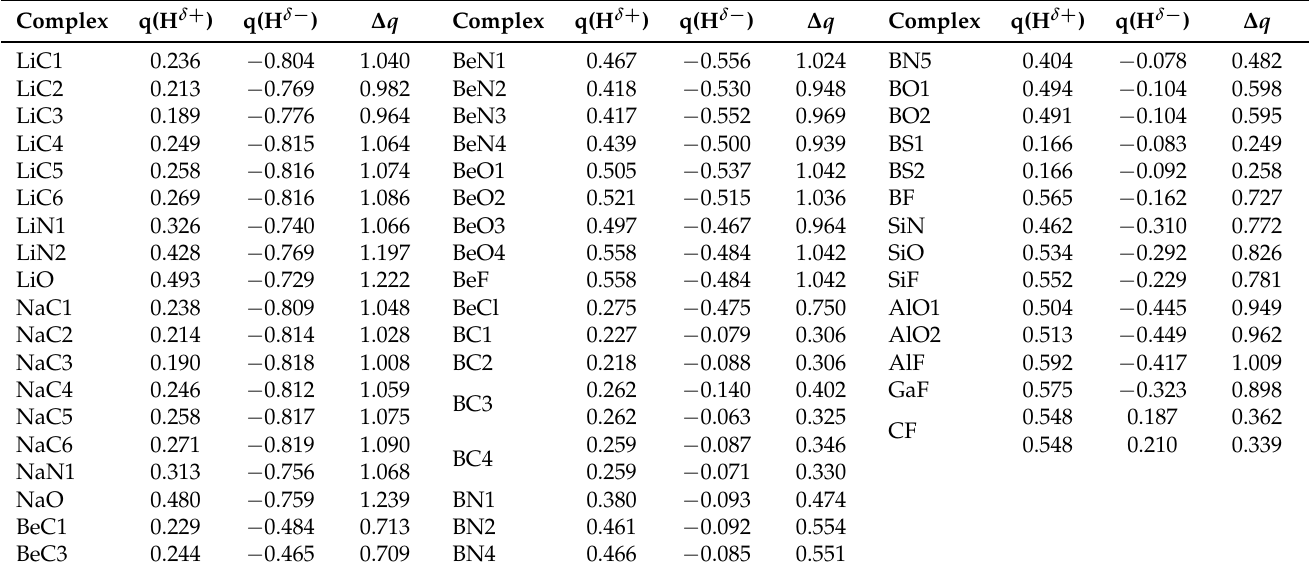
Table 1. Protonic and hydridic NBO charges (in e) for Group I. Protonic hydrogen charge q(H δ +